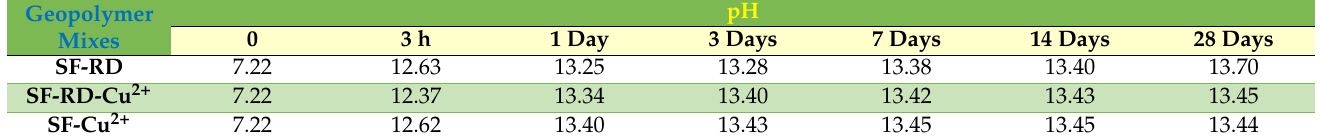
Table 6. pH’s values of leaching solutions of different mixes at different hydration ages.